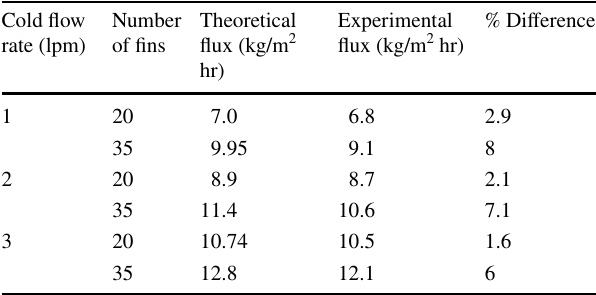
Fig. 7 Comparison of theoretical model with experimentation for dif- ferent feed flow rate Table 4 Comparison of permeate flux results from theoretical and experimental analysis